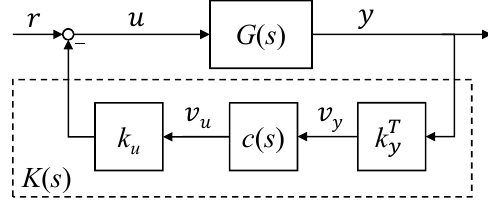
Figure 1. Block diagram representation of the blending